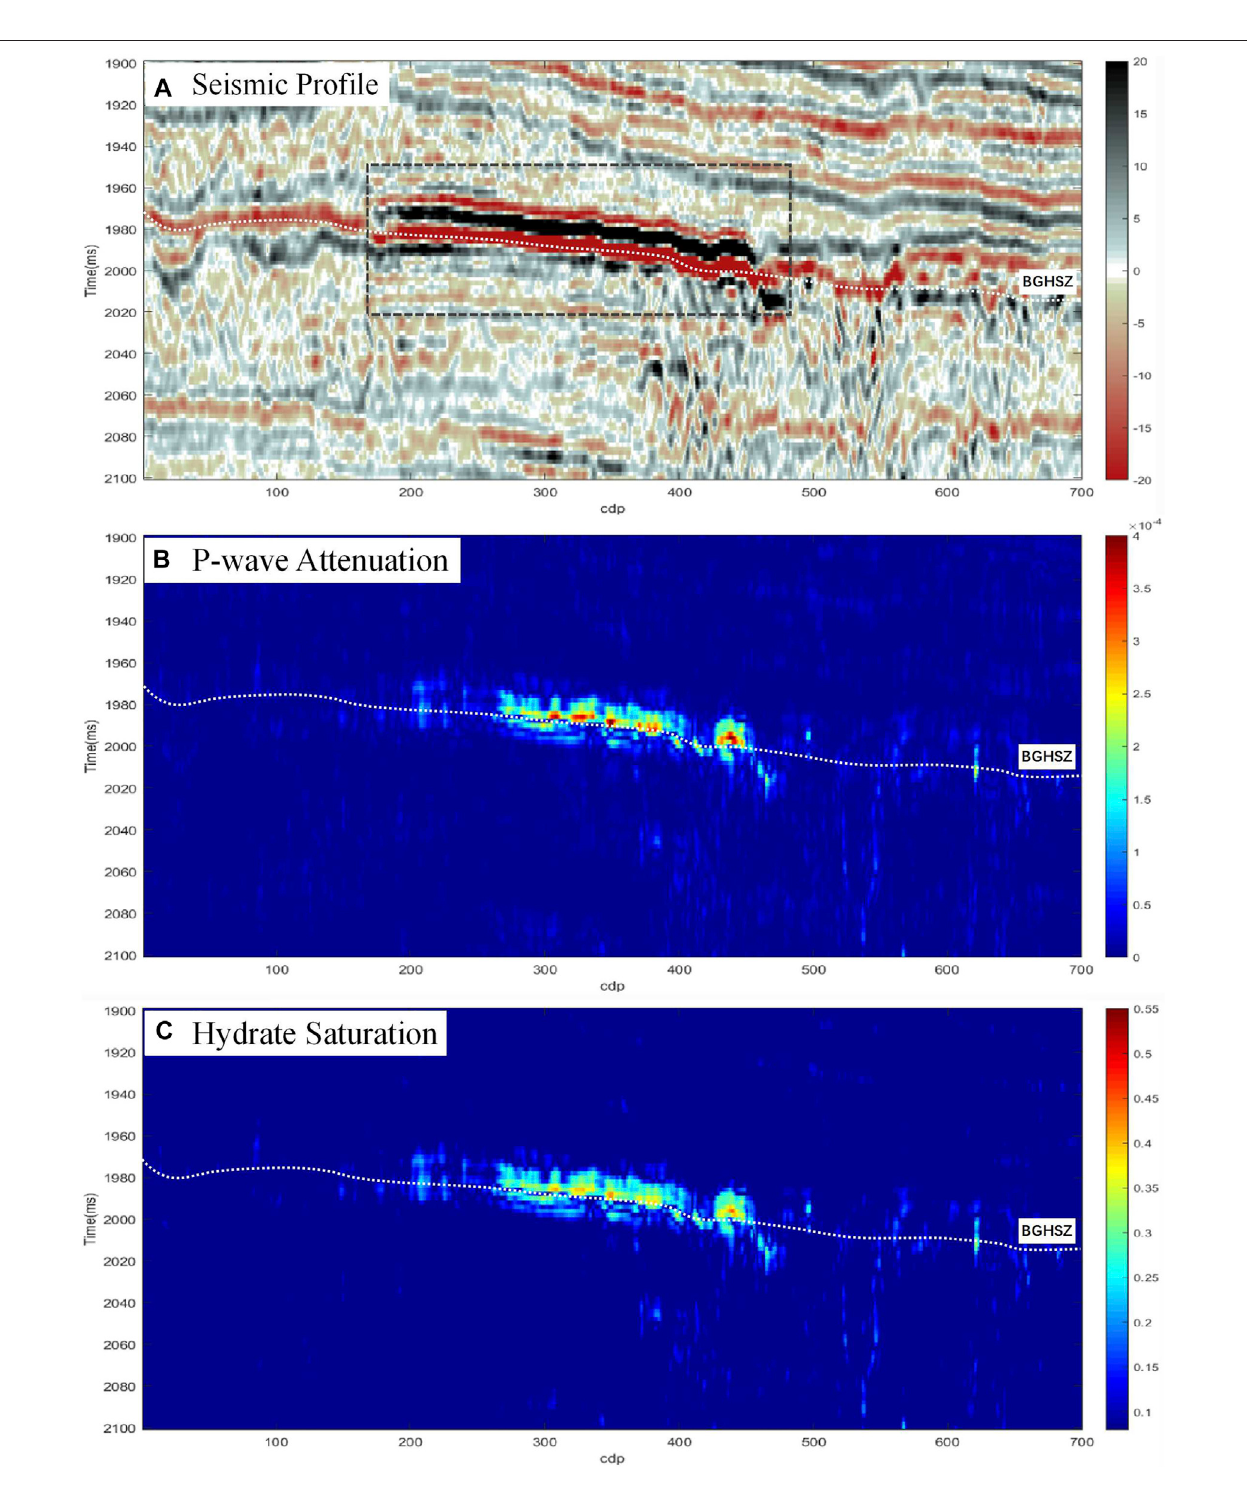
FIGURE 5 | Seismic (A) , attenuation (B) , and hydrate saturation (C) pro fi les of the study area. The white dotted line is the base of the gas hydrate stability zone (BGHSZ),abovewhichhydratesusuallydevelop.Theblackdottedlineboxistheboundaryofthetargetlayer.Thetargetlayerisbetweenthepeak(blackaxis)andtrough (red axis) with strong energy in the black dotted line box.